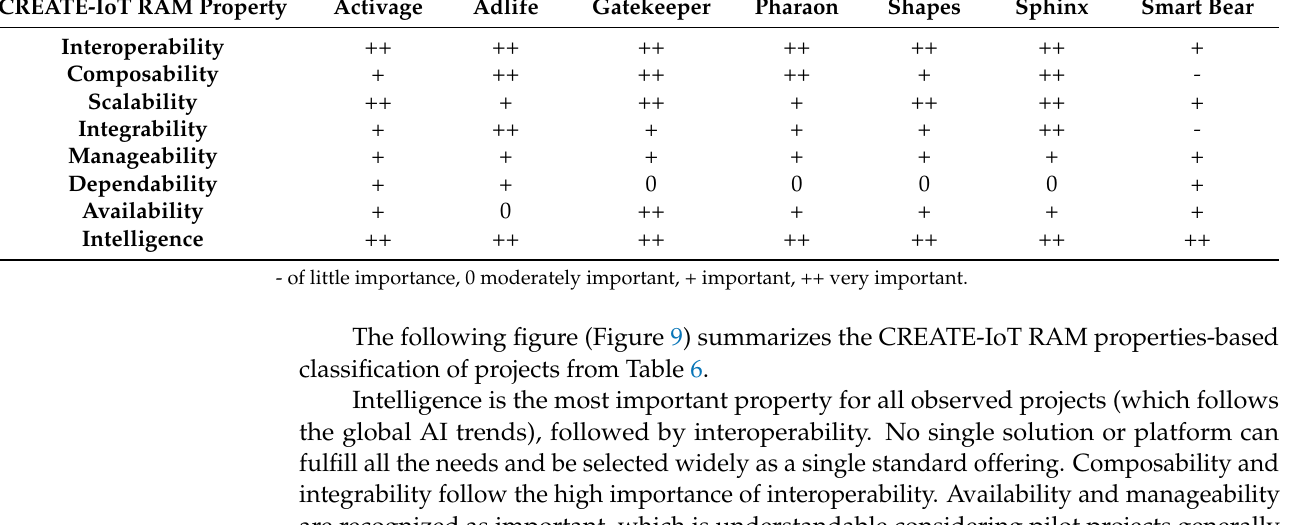
Table 6. Projects’ architectures addressing CREATE-IoT 3D RAM properties.